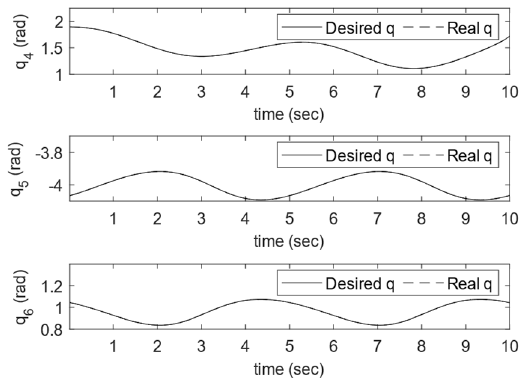
Figure 6. Trajectory tracking behavior of the robot using the proposed approach for the last three joints.